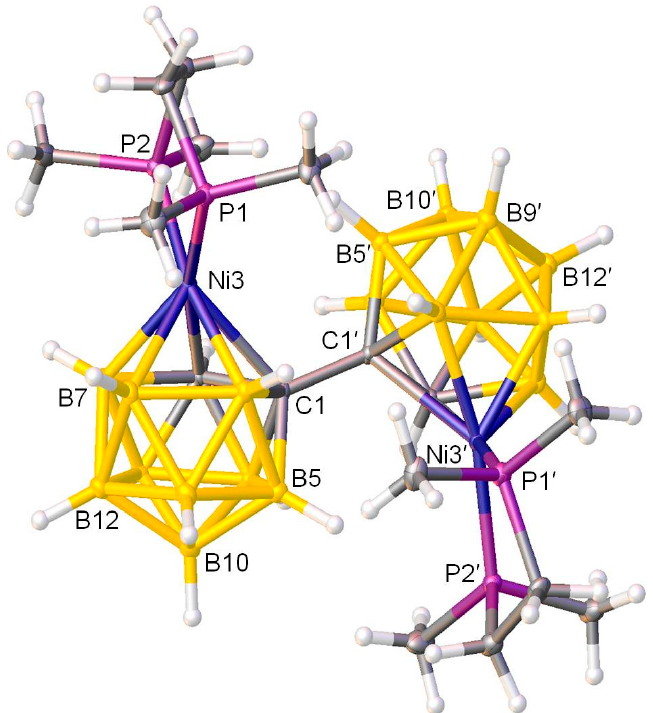
Figure 1. Molecular structure of rac -[1-(1 ′ -3 ′ -(dmpe)-3 ′ ,1 ′ ,2 ′ - closo -NiC 2 B 9 H 10 )-3-(dmpe)-3,1,2- closo - NiC 2 B 9 H 10 ] ( 1 ). Atoms with dashed suffixes are generated by the symmetry operation 1.5-x, y, 0.5-z.